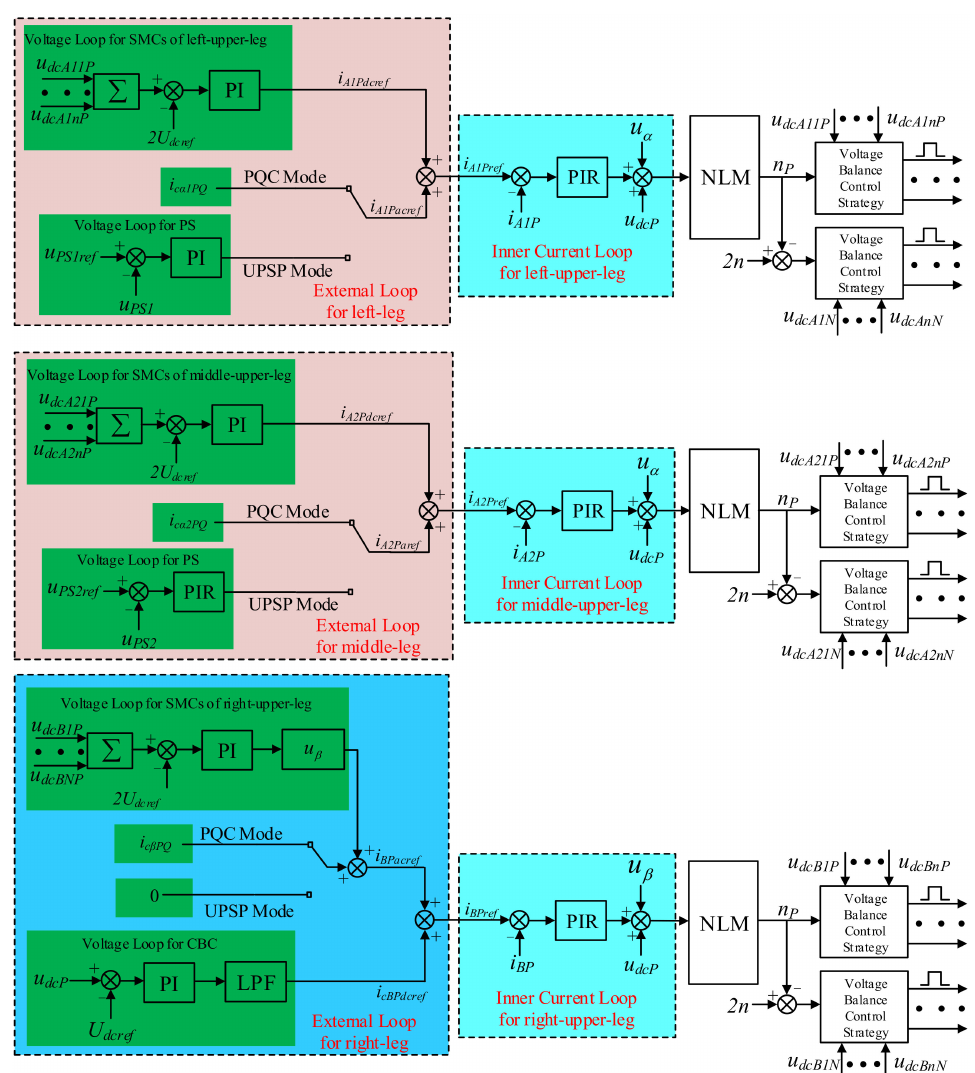
Figure 4. Control strategy of three-leg MMC-based